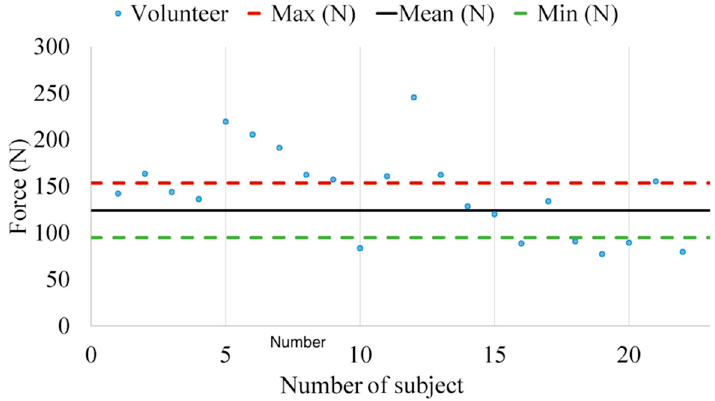
Figure 9. Maximum applied force distribution per volunteer.